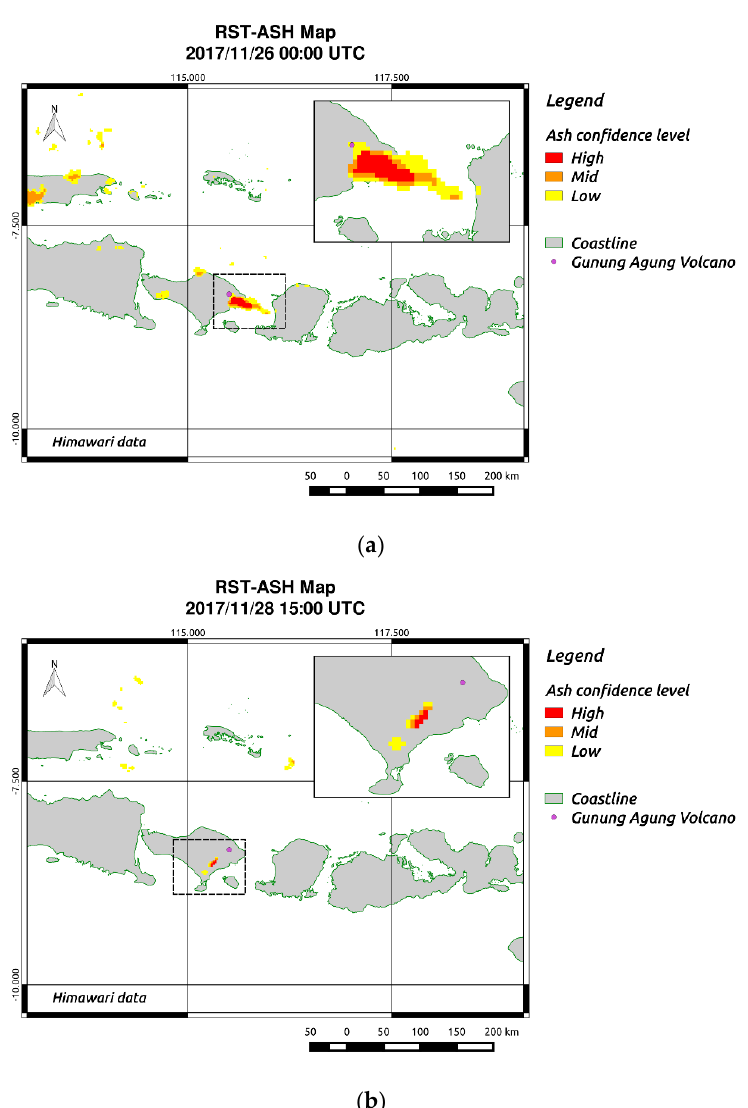
Figure 3. RST ASH maps (in yellow: 𝑇𝐼𝑅 ( 𝑥, 𝑦, 𝑡 ) < − 1 AND 𝑀𝐼𝑅−𝑇𝐼𝑅 ( 𝑥, 𝑦, 𝑡 ) > 0; in orange: 𝑇𝐼𝑅 ( 𝑥, 𝑦, 𝑡 ) < − 2 AND 𝑀𝐼𝑅−𝑇𝐼𝑅 ( 𝑥, 𝑦, 𝑡 ) > 0; in red: 𝑇𝐼𝑅 ( 𝑥, 𝑦, 𝑡 ) < − 3 AND 𝑀𝐼𝑅−𝑇𝐼𝑅 ( 𝑥, 𝑦, 𝑡 ) > 0) generated from infrared Himawari-8 data. ( a ) 26 November at 00:00 UTC; ( b ) 28 November at 15:00 UTC.